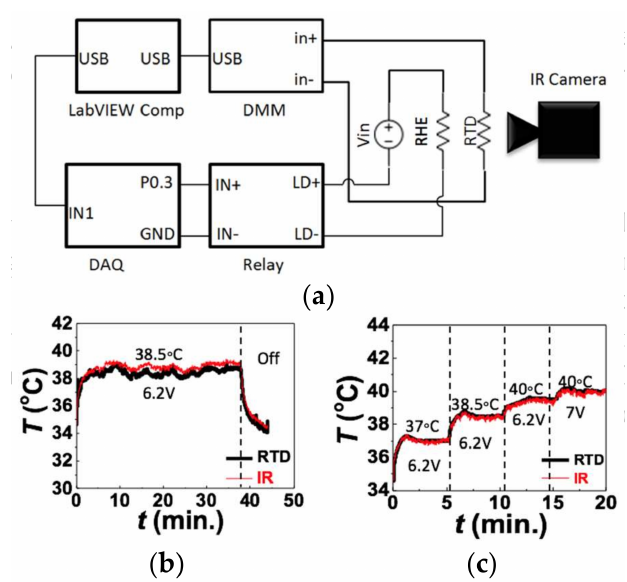
Figure 5. ( a ) Circuit diagram of set up for operating heater with PID control. DMM measures resistance of RTD and feeds it into a computer with LabVIEW, The LabVIEW program calculates the temperature of the RTD using the RTD’s starting temperature, starting resistance and calibration constant. It then uses a PID algorithm to calculate the optimal duty cycle for PWM of the heater given the heater’s current temperature and the set point temperature for the heater. The LabVIEW program then uses the data acquisition unit (DAQ) to switch the relay on and off with the determined duty cycle, thus controlling how much total power is fed to the heater; ( b ) Temperature of the heater versus time measured with both the RTD and the IR camera as the heater is turned on at a set point of 38.5 ◦ C and then turned off. Heater is able to maintain set point temperature for an extended period of time; ( c ) Temperature of the heater versus time measured with both the RTD and the IR camera as the set point of the heater is changed while the voltage remains constant. At 40 ◦ C, 6.2 V is not sufficient for the heater to reach the set point, so the voltage is increased to 7 V, at which point the heater is able to reach and maintain a temperature of 40 ◦